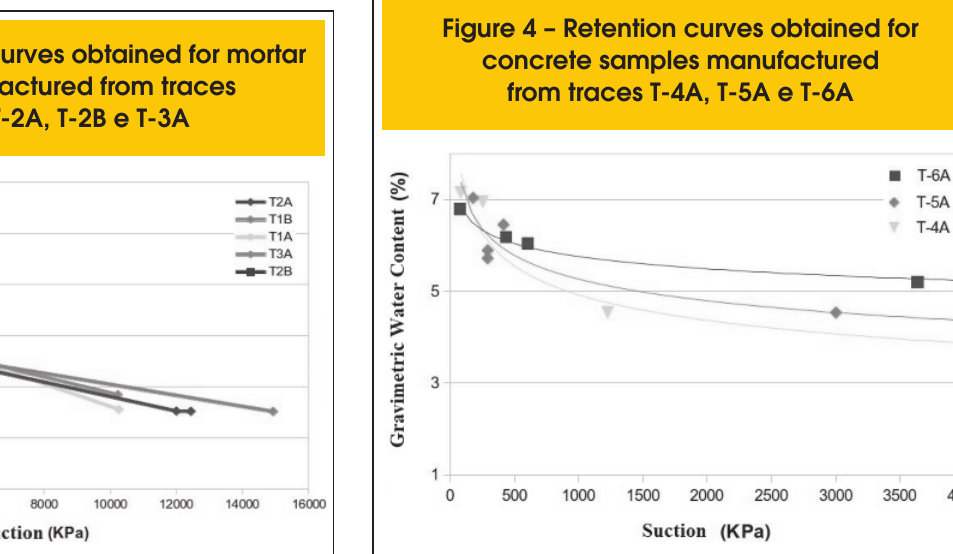
Figure 4 – Retention curves obtained for concrete samples manufactured from traces T-4A, T-5A e